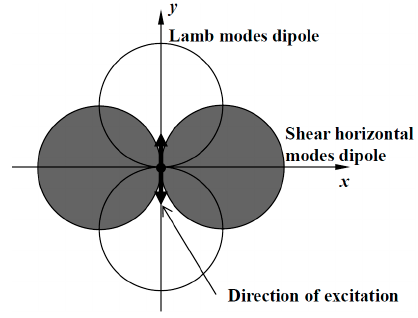
Figure 1. Pair of dipole patterns excited by a point surface shear source. The lobes of the Lamb modes dipole are in opposition of phase, whereas the lobes of the SH dipole are in phase.